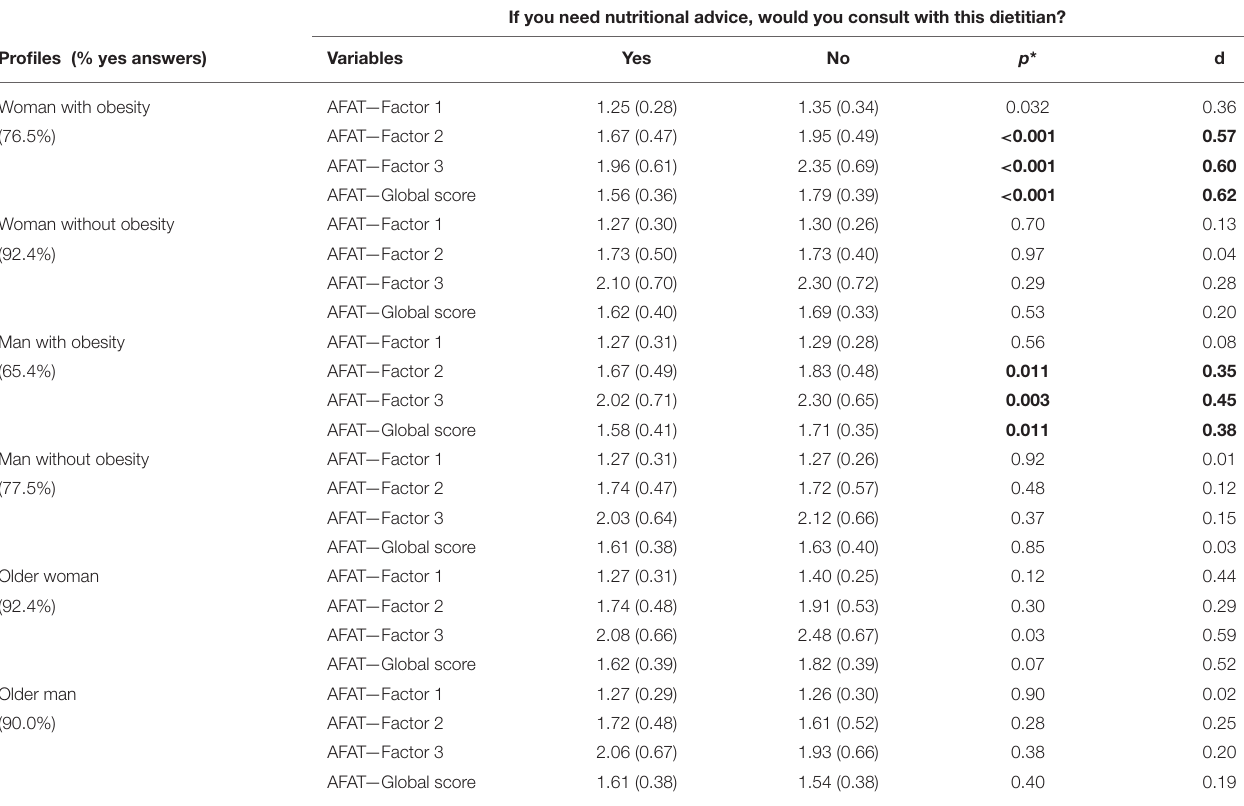
TABLE 3 | Laypeople’s willingness to consult each dietitian profile and Antifat Attitudes Test (AFAT) scales. If you need nutritional advice, would you consult with this